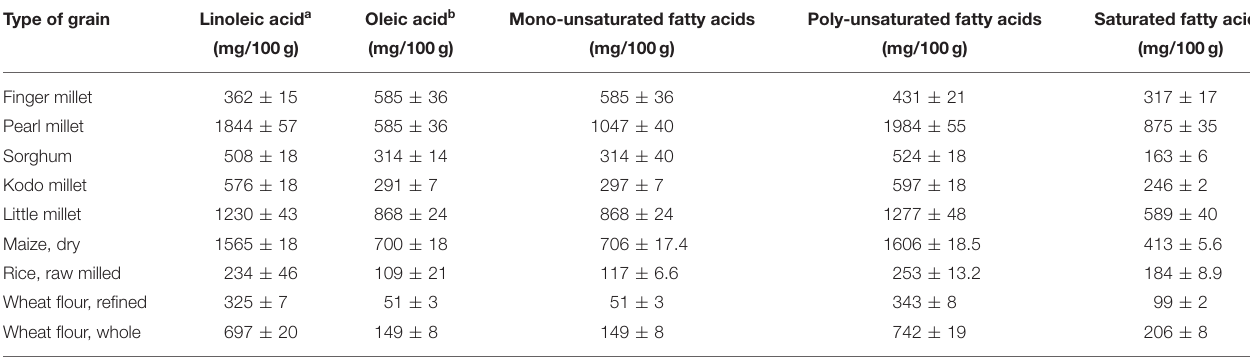
TABLE 2 | Fatty acid profile of the millets in comparison to other staple foods. Type of grain Linoleic acid a Oleic acid b Mono-unsaturated fatty